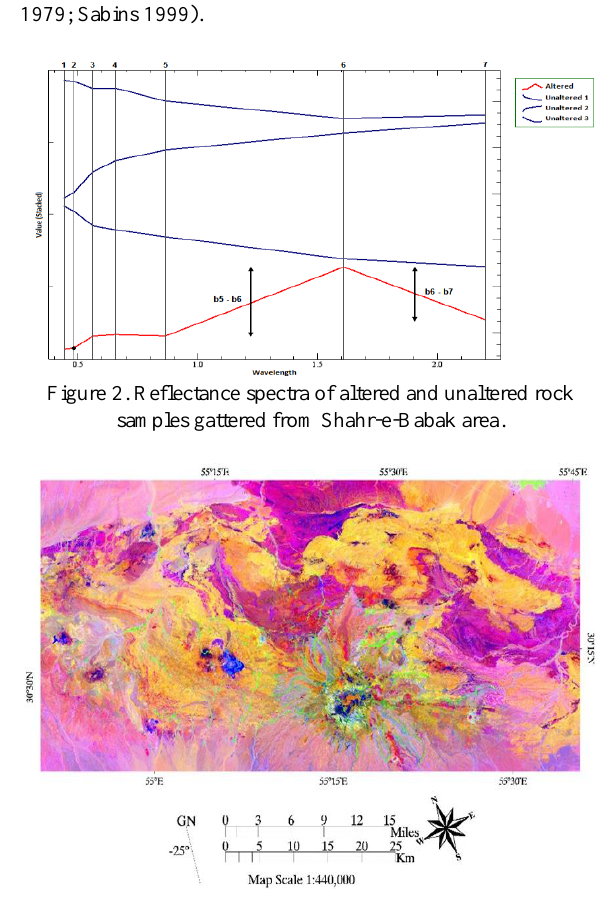
Figure 3. FCC image of RGB=2, 6-7, 5-6 shows altered rocks as blue color spots.